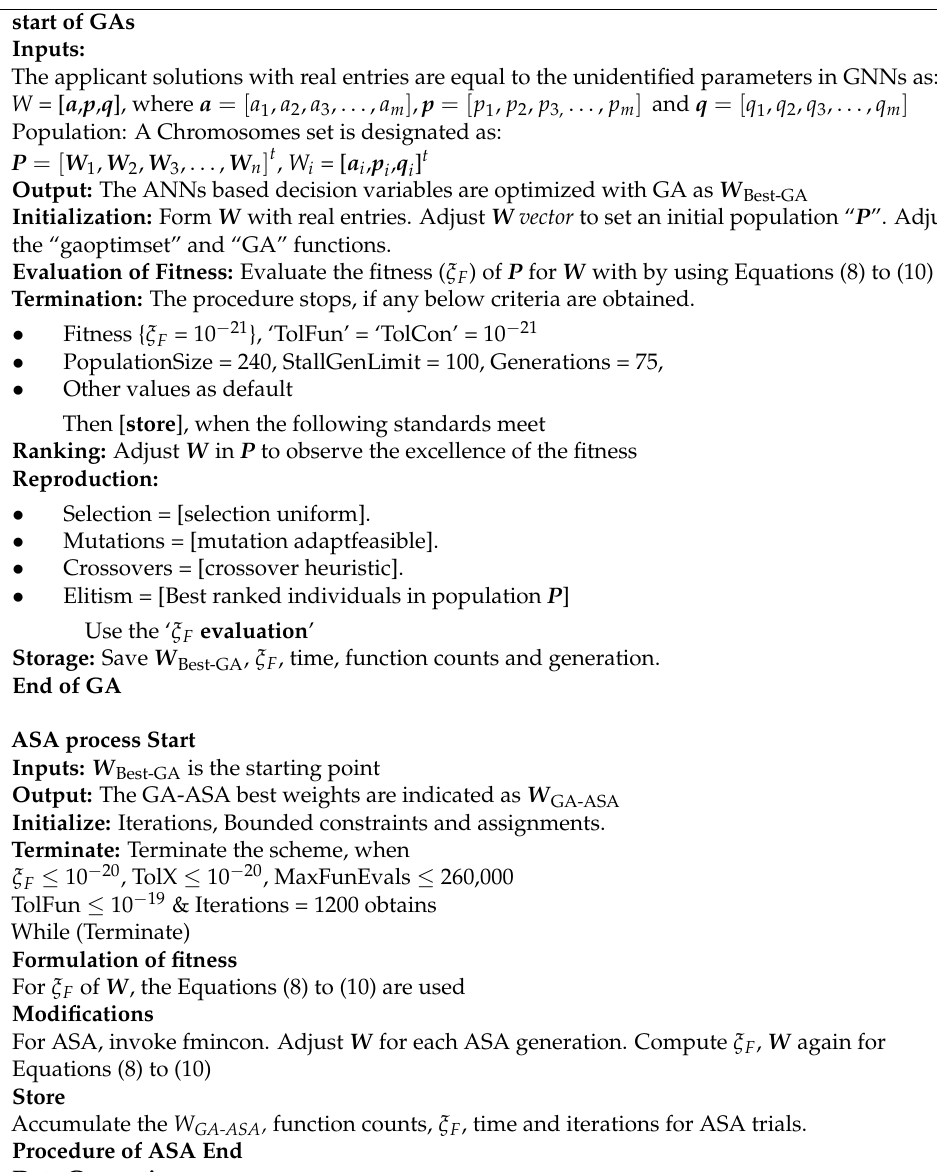
Table 1. Optimization procedures-based GA-ASA to solve the